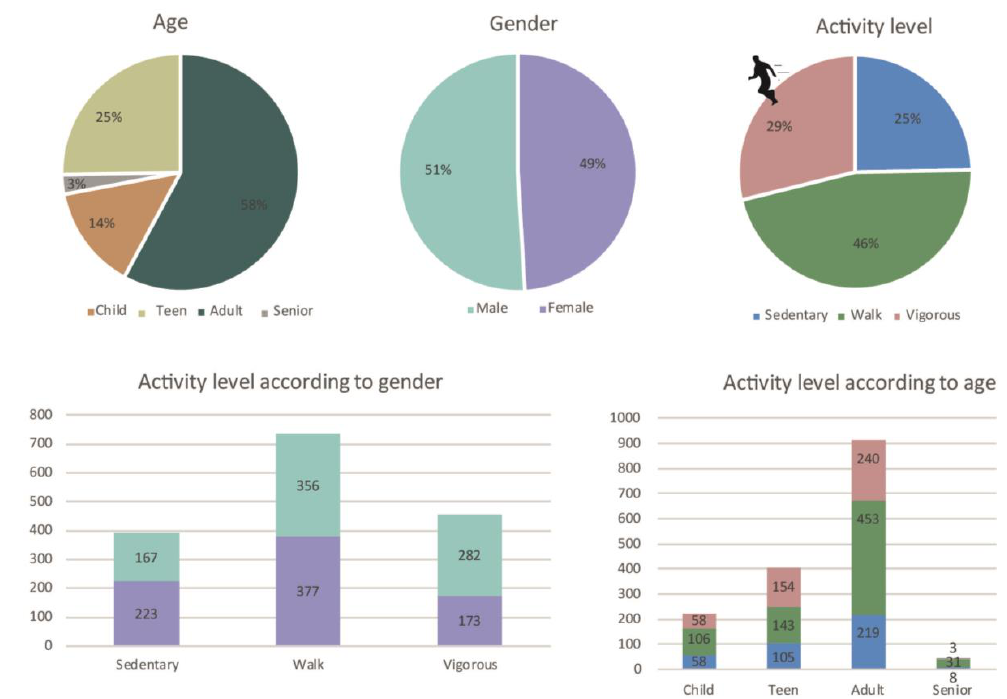
Figure 5. Observed age, gender and activity level on Guldbergs Plads.